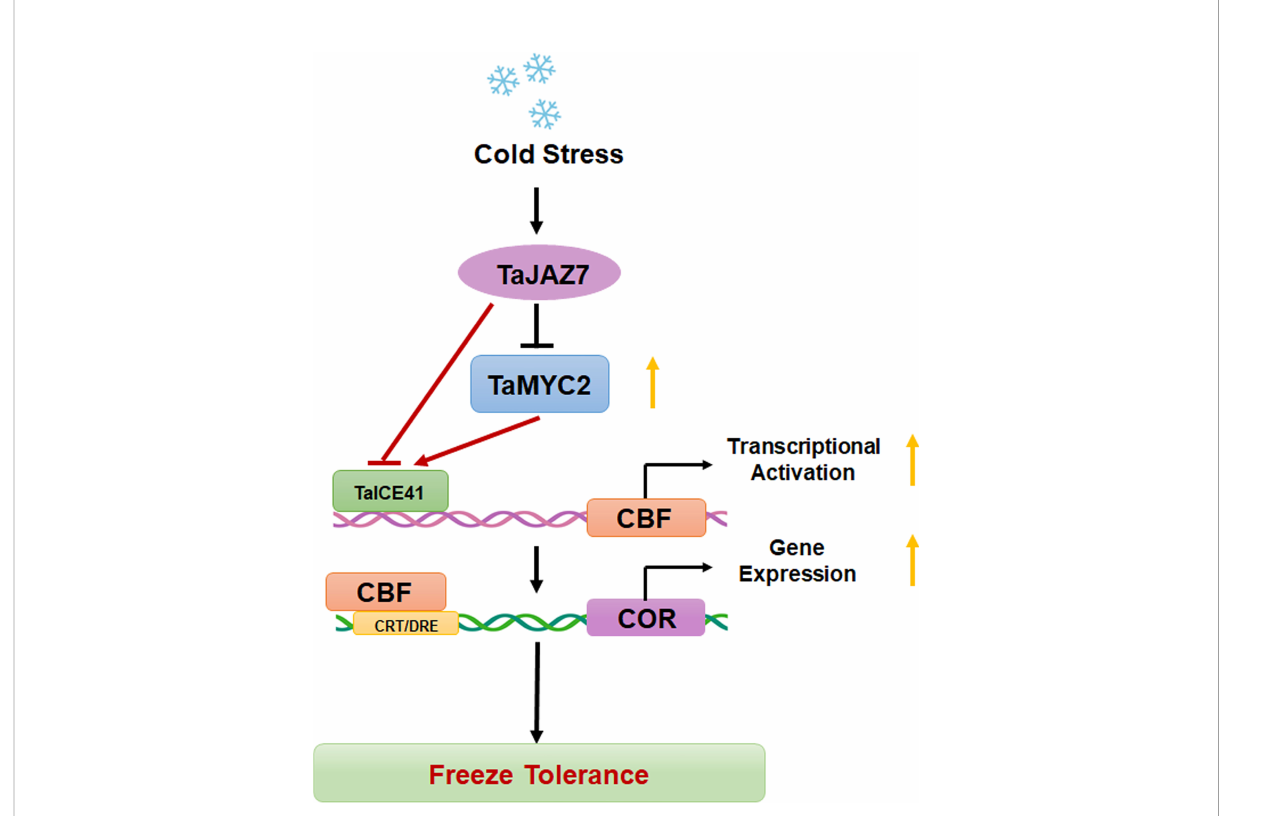
FIGURE 7 Working model diagram of the TaMYC2-TaICE41 module regulating cold stress in wheat. Yellow arrows represent the trends in gene